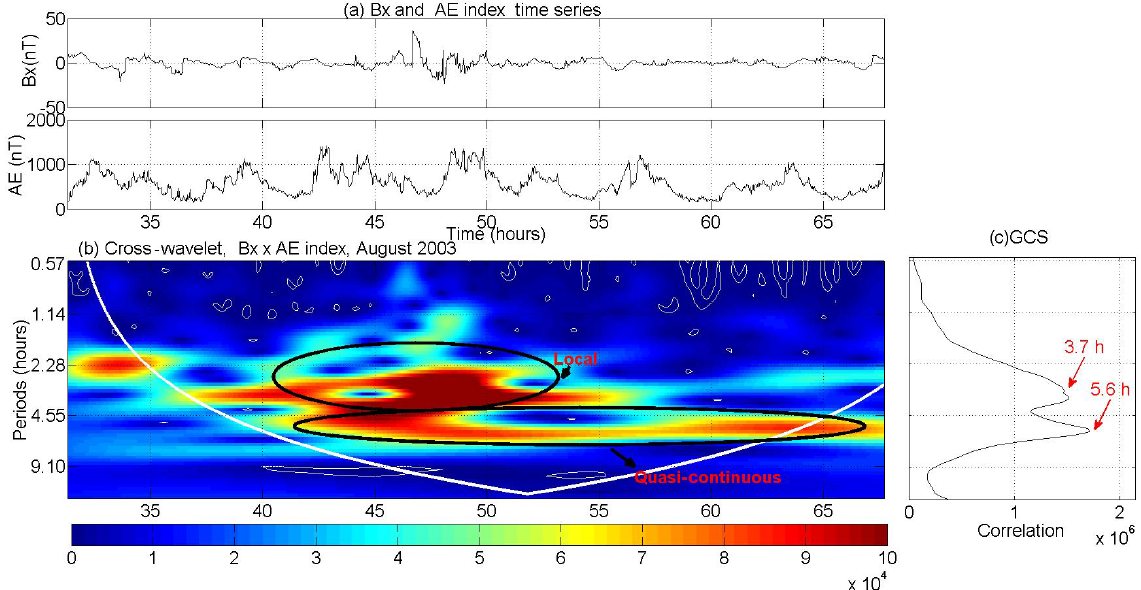
Figure 8. (a) Filtered B x geomagnetic magnetotail component and AE index time series. (b) CWT for the HILDCAA event that occurred between 15:11UT on 20 August, and 15:43UT on 24 August 2003. (c) Global correlation spectrum. In (a) and (b) , the x axes represent the number of hours after the HILDCAA event started.